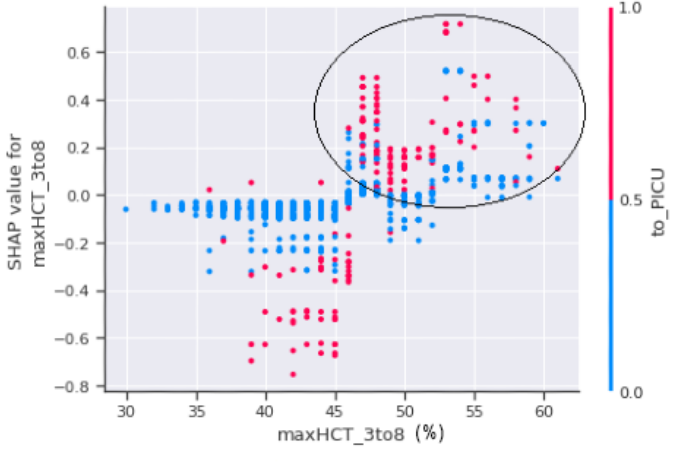
Figure 11. SHAP dependence plot between maxHCT_3to8 and to_PICU.